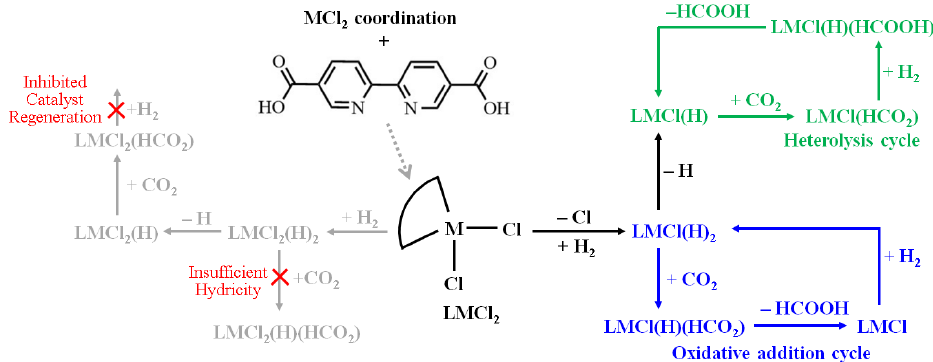
Figure 1. Proposed reaction pathways of CO 2 reduction by LMCl 2 complexes. The gray pathways are unfavorable cases; green and blue pathways are accessible cases.